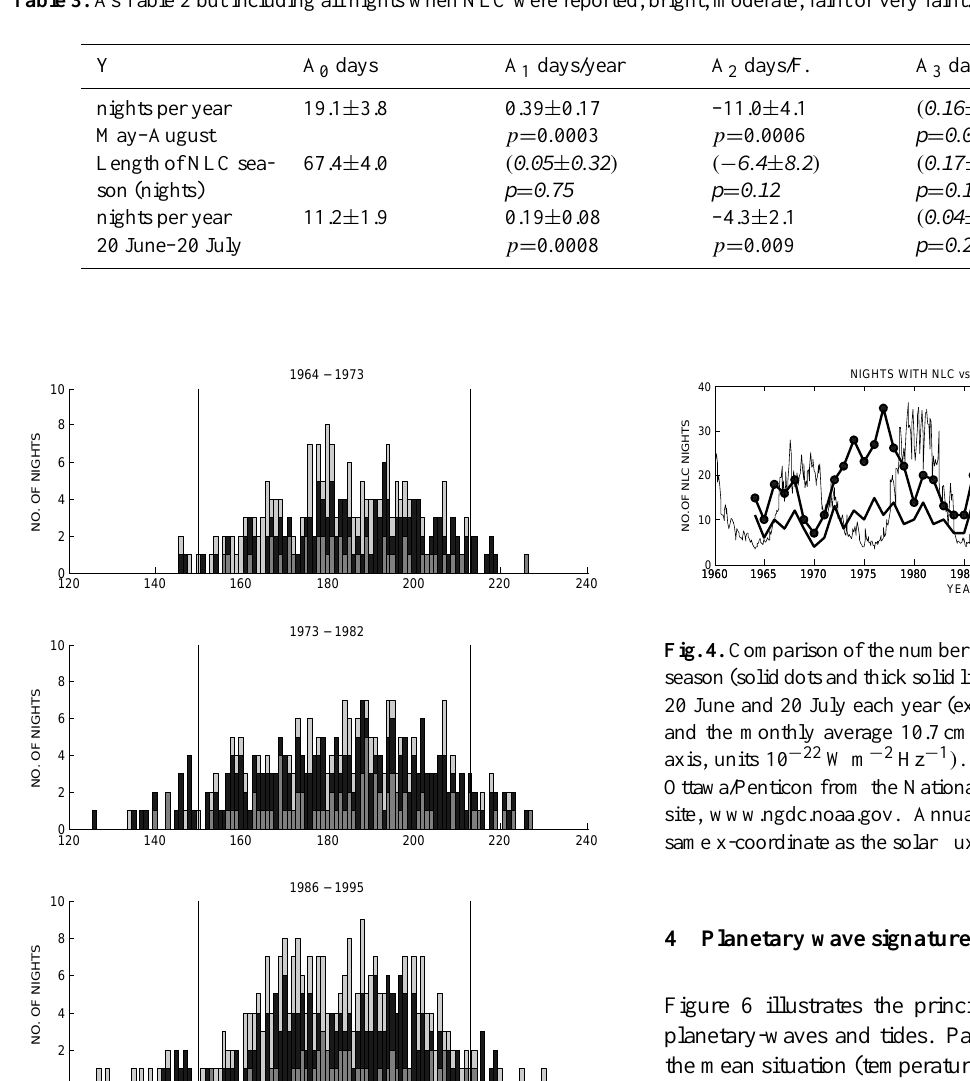
Table 3. As Table 2 but including all nights when NLC were reported, bright, moderate, faint or very faint.